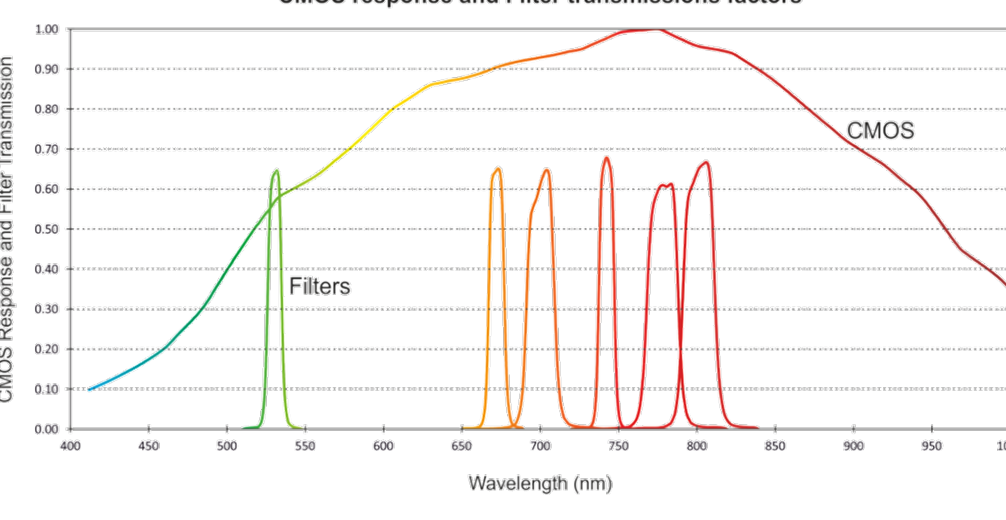
Table 2. Characteristics of the six channels of the camera and their corresponding exposures